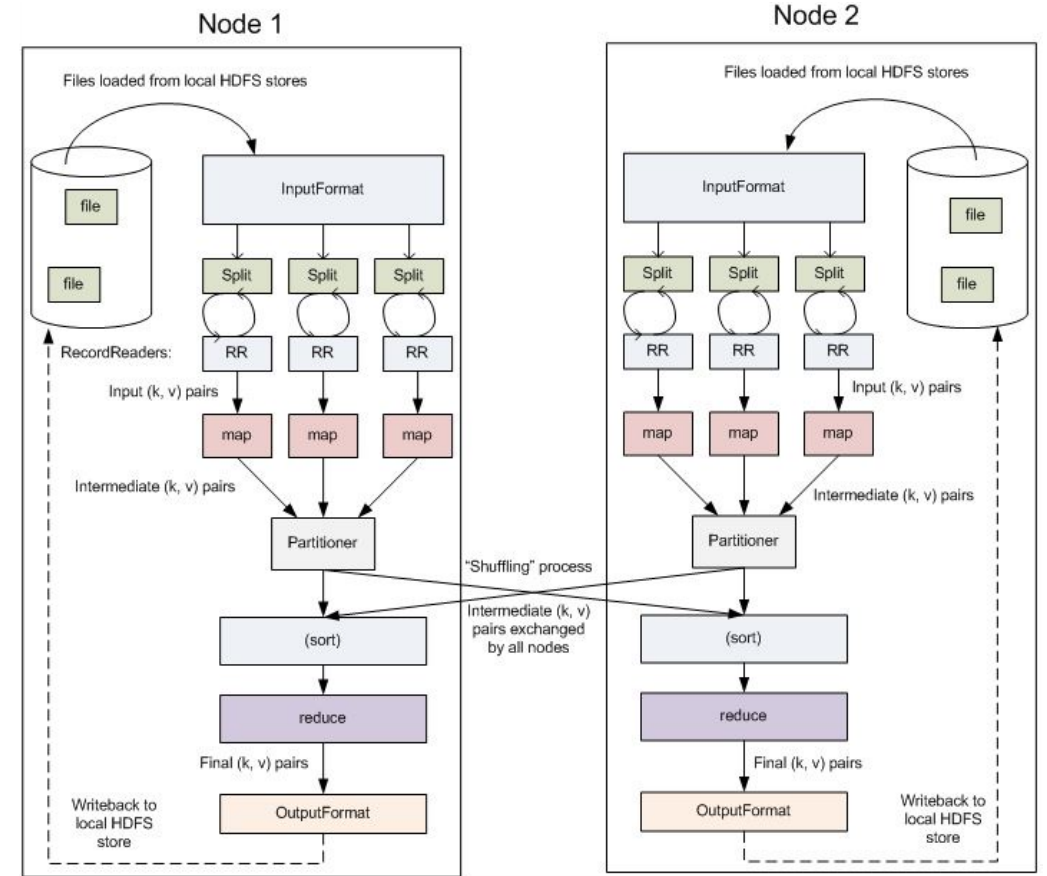
Figure 6. MapReduce Computational Paradigm